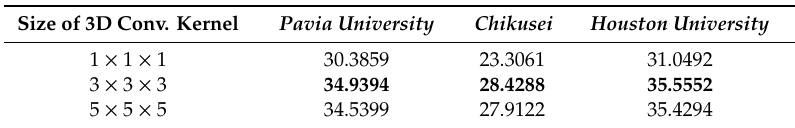
Table 6. PNSR (dB) indices of the sensitivity analysis of MW-3D-CNN over the size of 3D convolutional kernels. The upscaling factor is two.